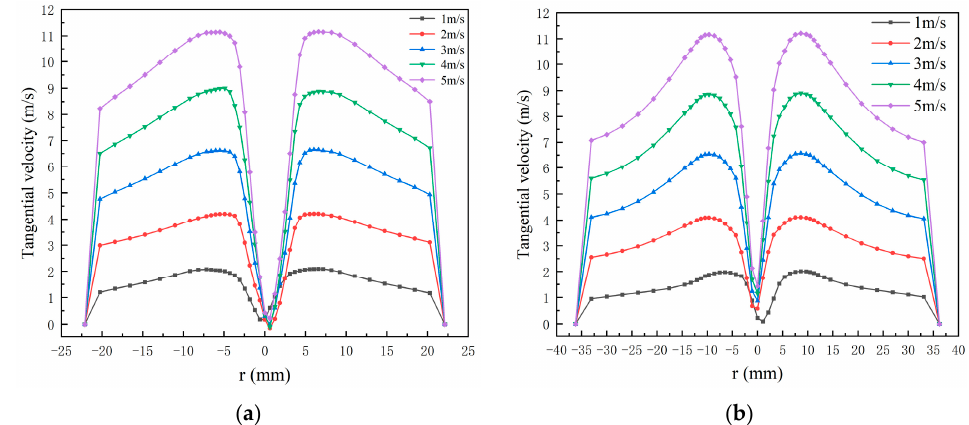
Figure 7. Distribution of the tangential velocity. ( a ) z 1 = 90 mm; ( b ) z 2 = 170 mm.